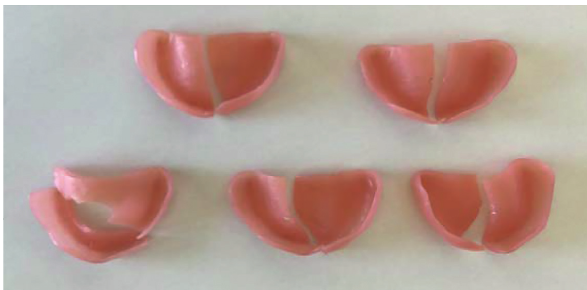
Figure 18: RS Vertex ® prosthesis bases subjected to pH 4 after fracture.